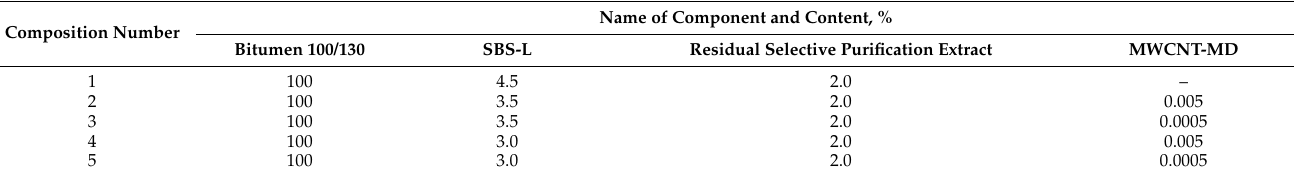
Table 7. Component composition of polymer-modified binder